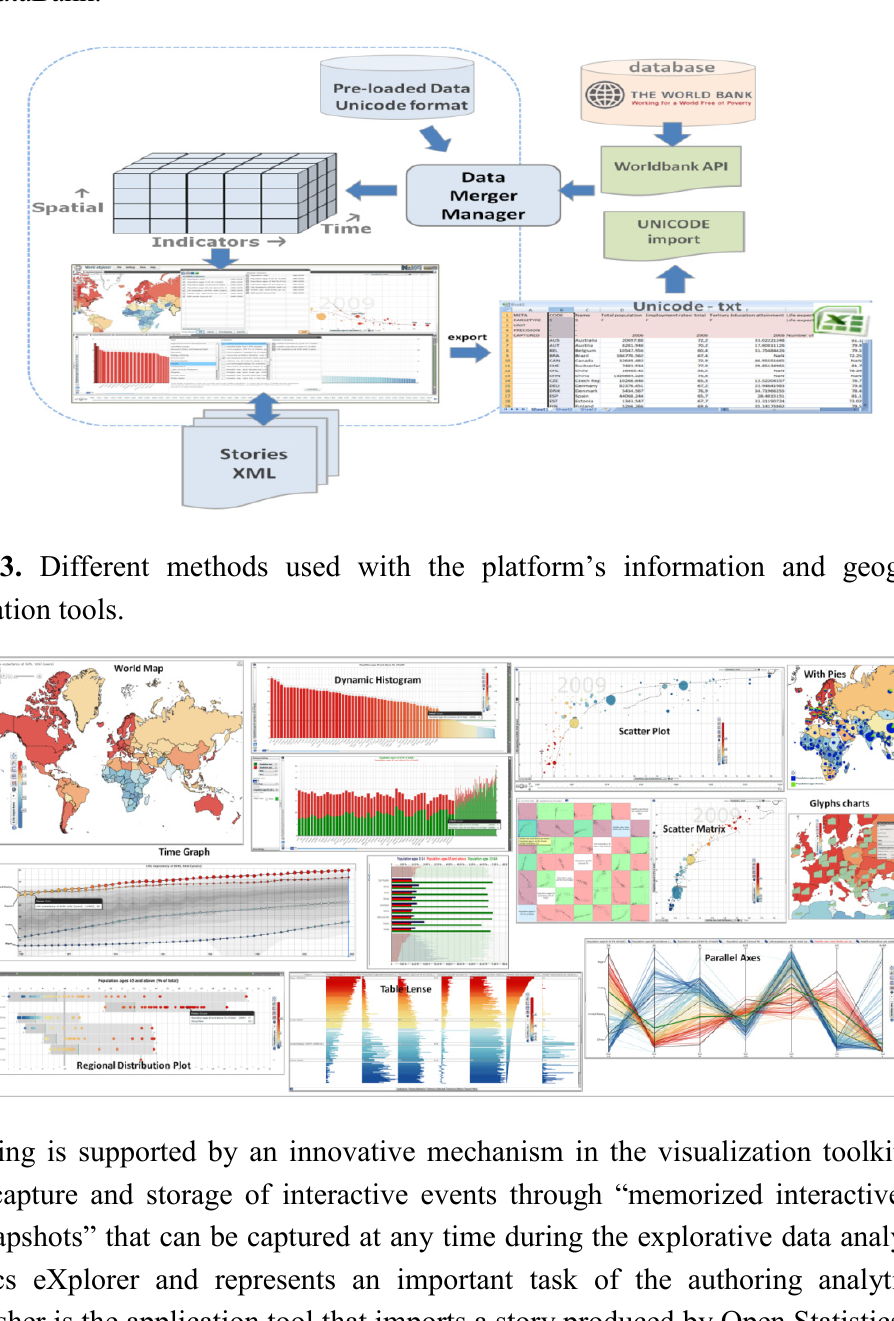
Figure 2. The Open Statistics eXplorer provides open data architecture for flexibility. This data interface is based on a programmed application program interface (API) to the World dataBank.